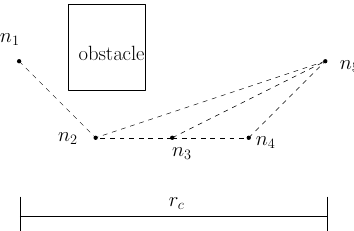
Figure 1. I has five vertices n 1 , n 2 , n 3 , n 4 , n 5 . There is a rectangular obstacle. Also, the length of r c is depicted at the bottom of this figure. Each edge in I is plotted with dashed line segments. See that each edge length is shorter than r c and that each edge is a collision-free